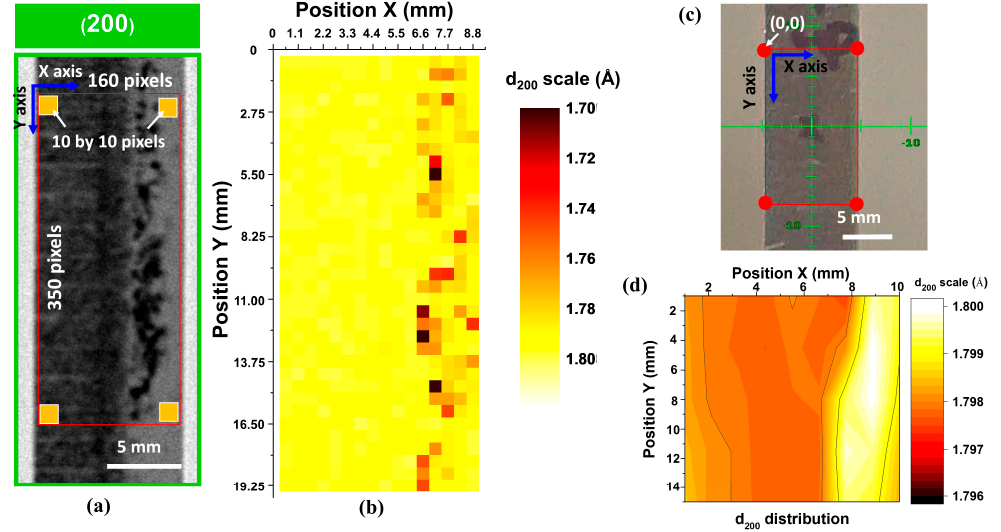
Figure 8. ( a ) A (200) Bragg-edge radiograph displaying the imaging data analysis details, and ( b ) the distribution of the (200) interplanar spacing (d200) for the dual Col. sample (no loading) determined by iBeatles fitting. The mapping analysis was conducted over a sample area of 19.25 × 8.80 mm 2 and the value in each point is based on fitting spectra in 10 pixel × 10 pixel areas. ( c ) A photograph of the dual Col. sample showing the coordinate of the neutron diffraction scanning method, and ( d ) the distribution of the (200) interplanar spacing for the dual Col. sample derived from neutron diffraction.